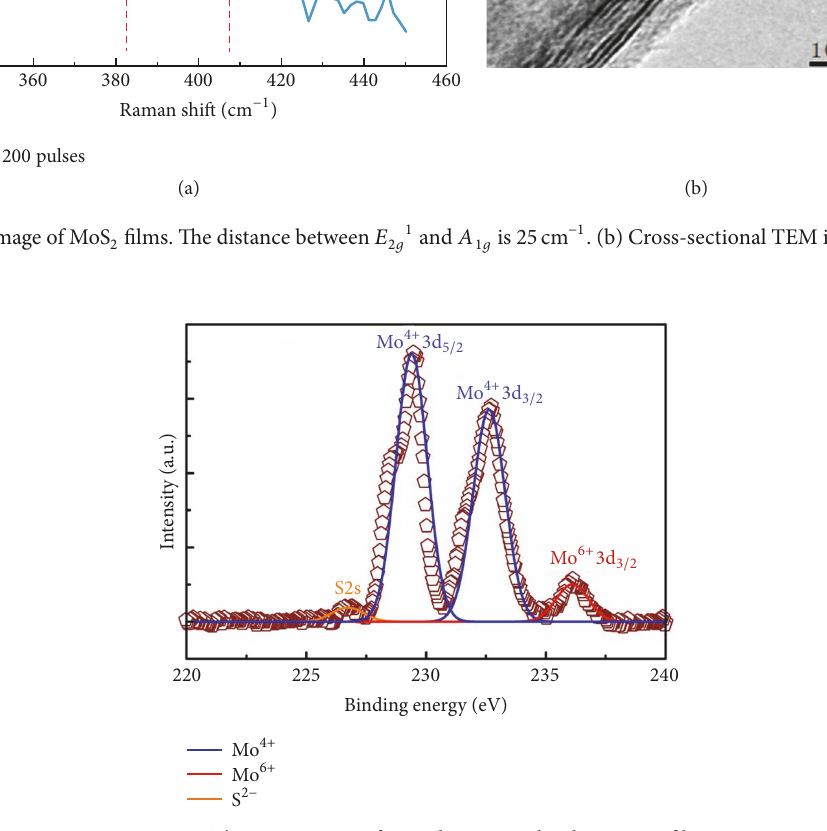
Figure 3: The XPS spectra of Mo 3d, S 2s core levels in MoS 2